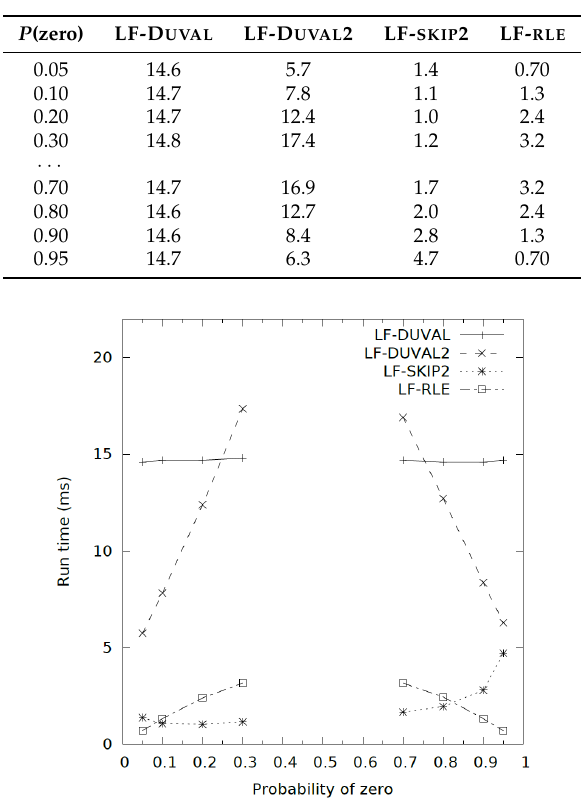
Figure 5. Comparison of the algorithms on random binary sequences (5 MB) with a skew